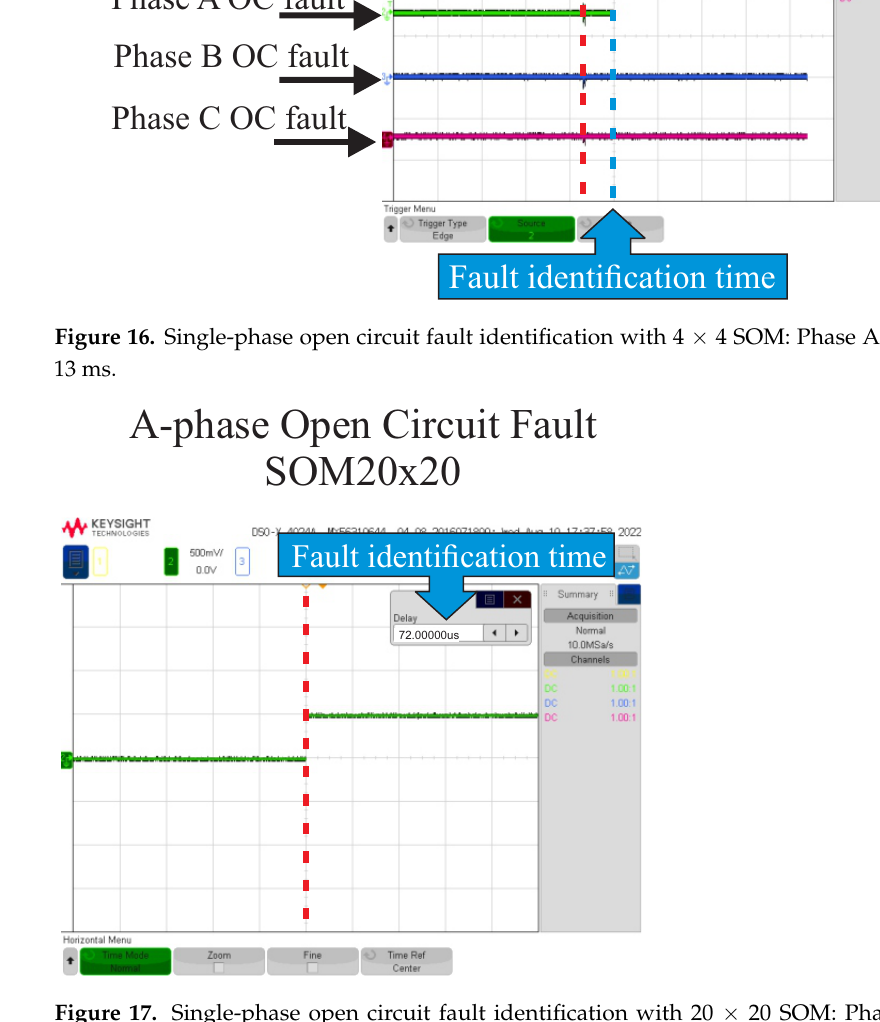
Figure 17. Single-phase open circuit fault identification with 20 × 20 SOM: Phase A; detection time 70 µ